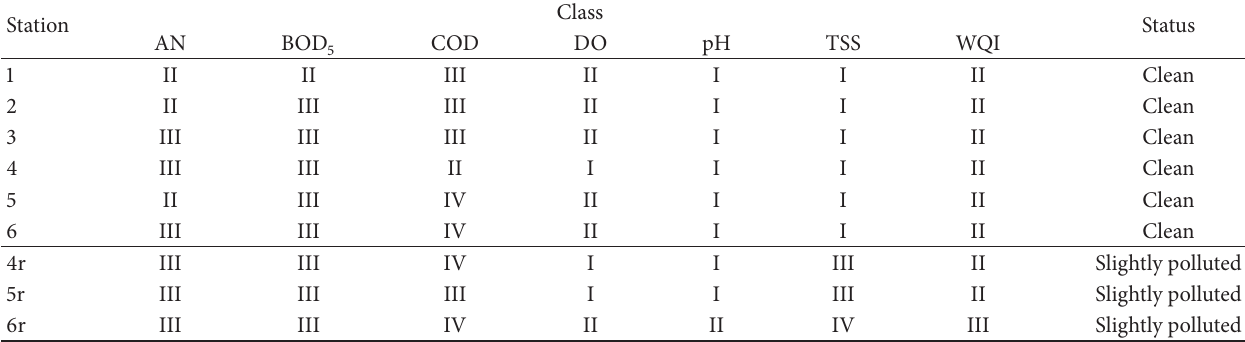
Table 4: Classification of water quality of the six sampling stations before and after rain according to WQI.